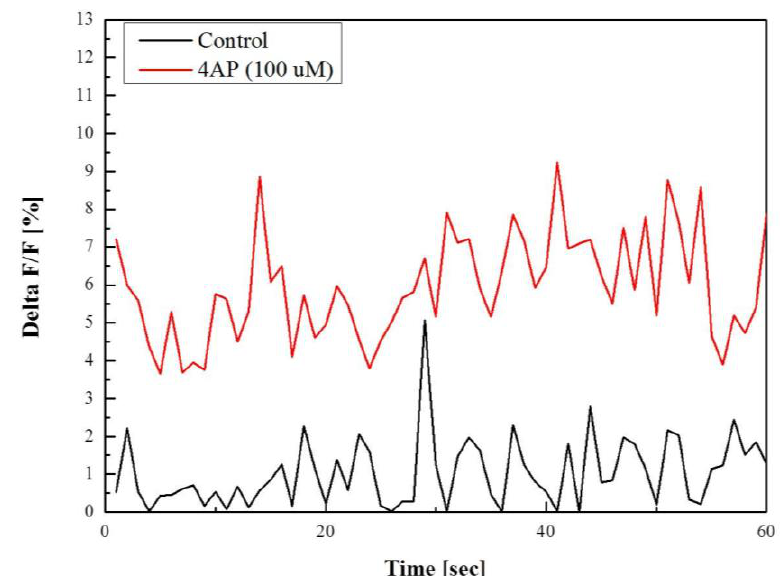
Figure 10. The calcium oscillation in neuroblastoma cells: control cells (black line) and 30 min after the injection of the 4-AP with 100 µM (red